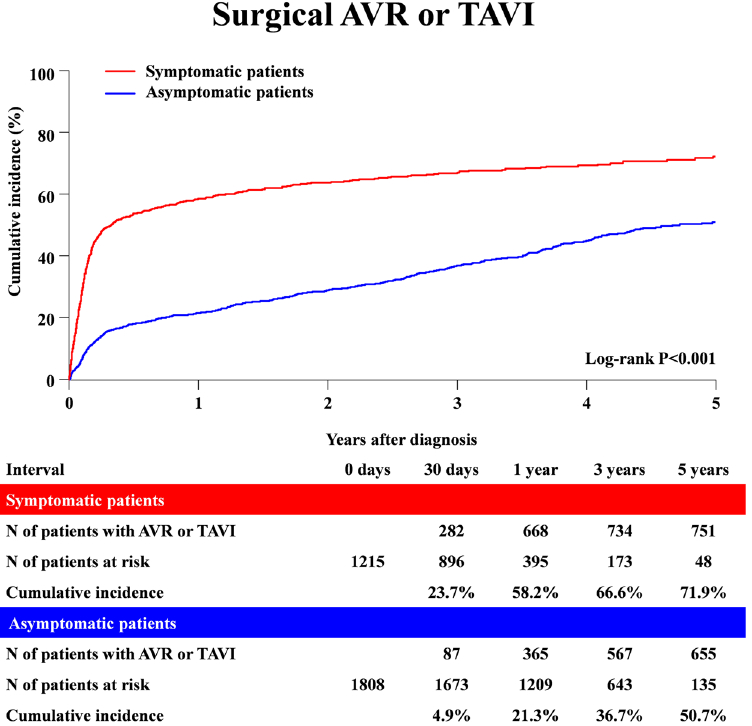
Figure 2. Cumulative incidence of surgical AVR or TAVI: Symptomatic versus Asymptomatic patients. AVR = aortic valve replacement; TAVI = transcatheter aortic valve